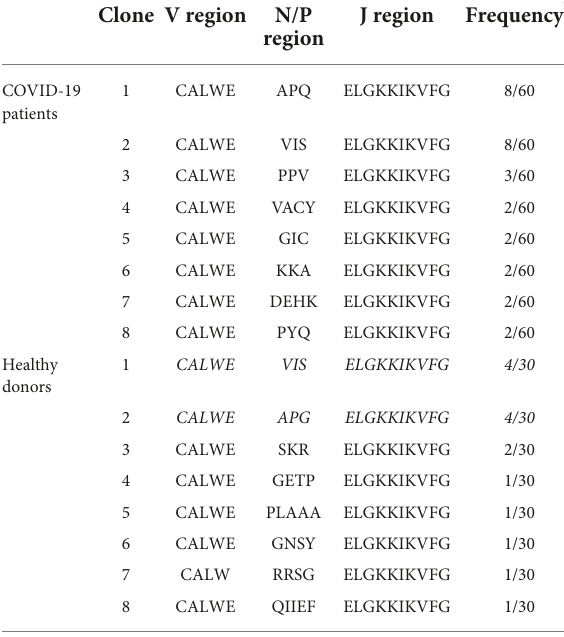
TABLE 3 Deduced V δ 2 CDR3 amino acid sequences of COVID-19 patients and healthy donors a